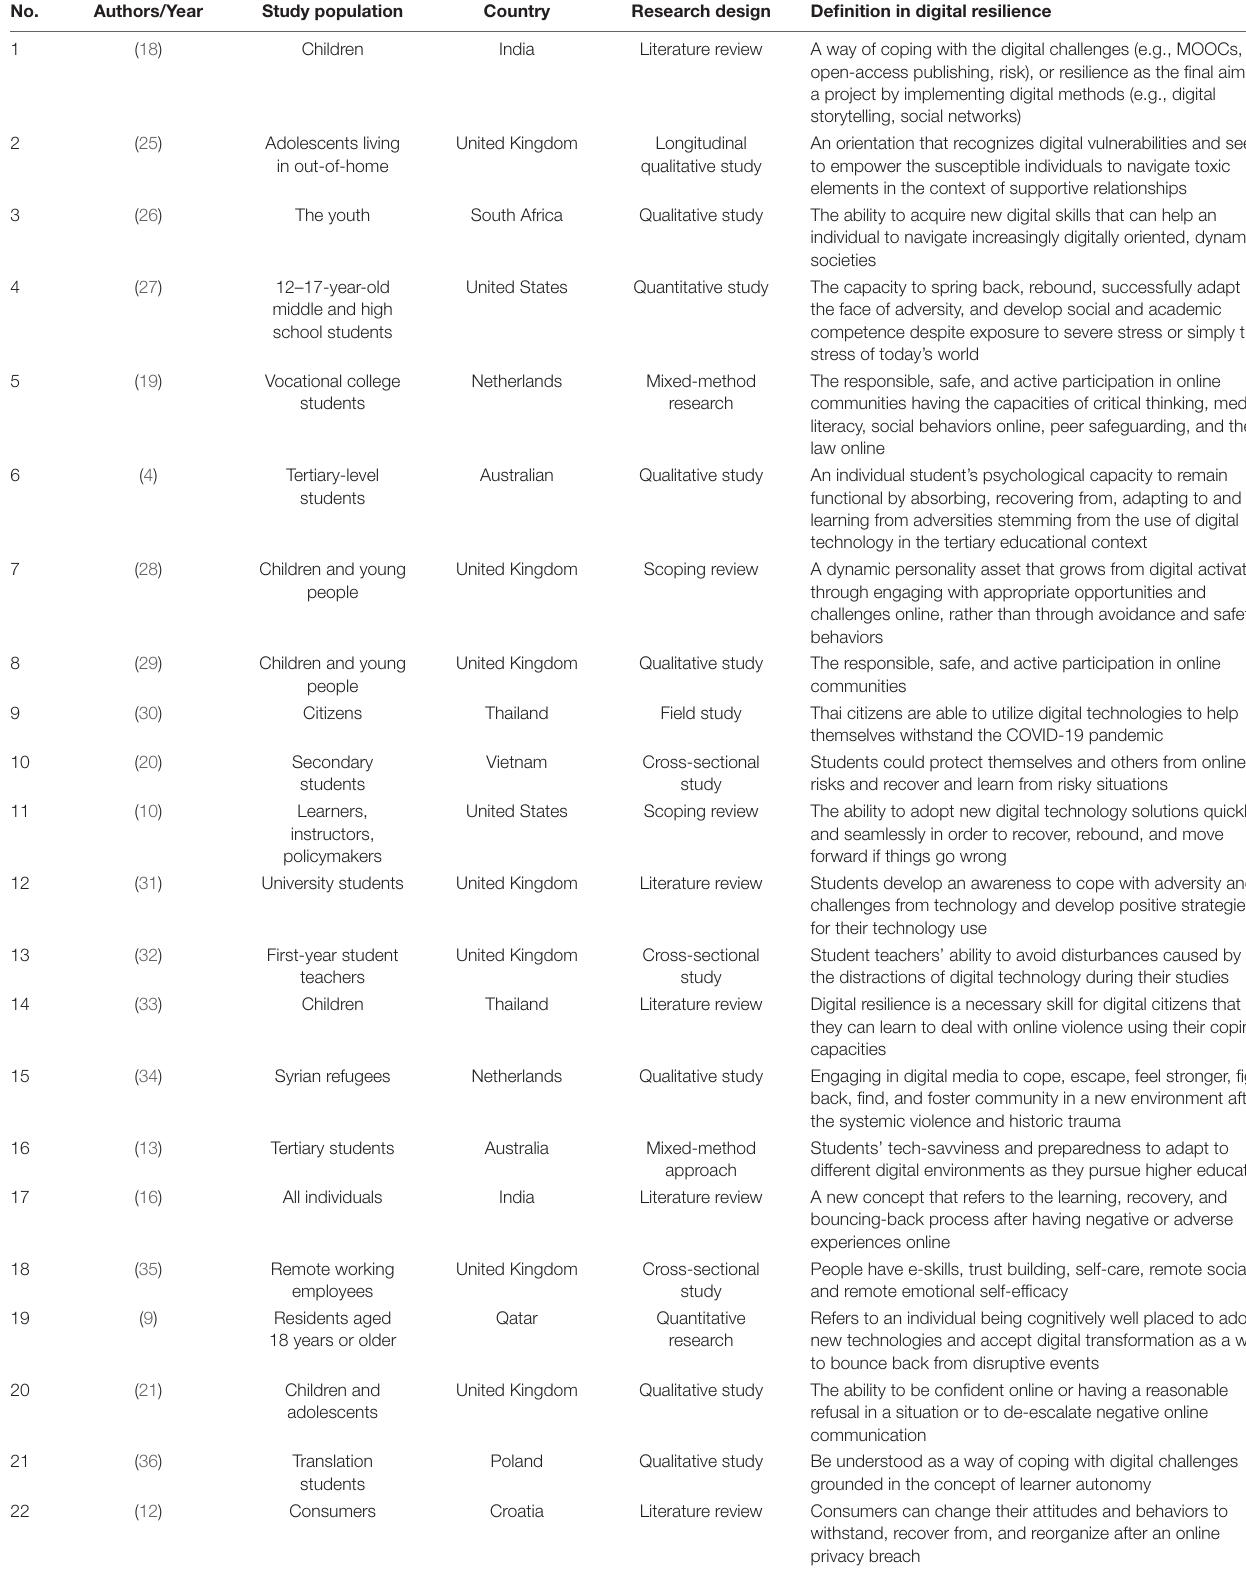
TABLE 2 | Articles included for the final